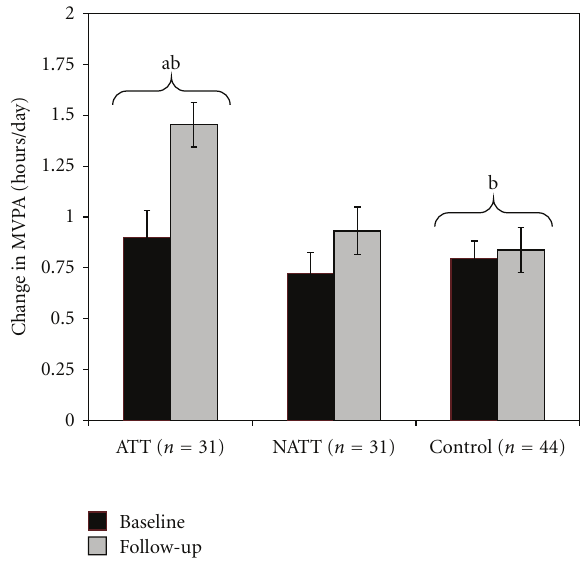
Figure 1: Baseline (black bars) and follow-up (grey bars) measures of MVPA by group. Values are means ± SE. (a) Significant di ff erence from baseline to follow-up measures; (b) change from baseline to followup is significantly di ff erent between ATT and Control